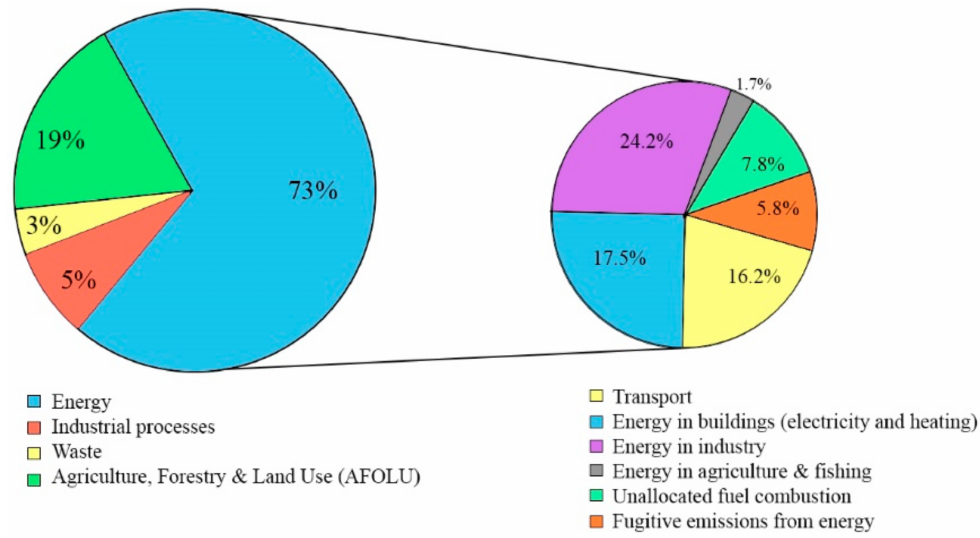
Figure 1. The share of global greenhouse gas emissions (%) from buildings consuming energy